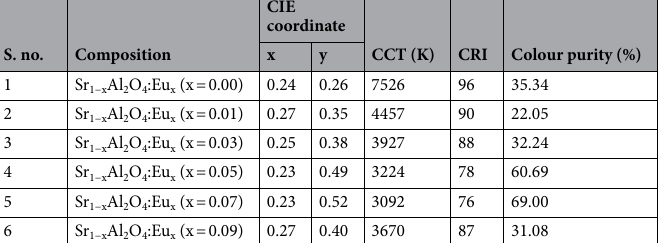
Table 5. Composition, CIE coordinate (x,y), correlated colour temperature (CCT) and colour purity for